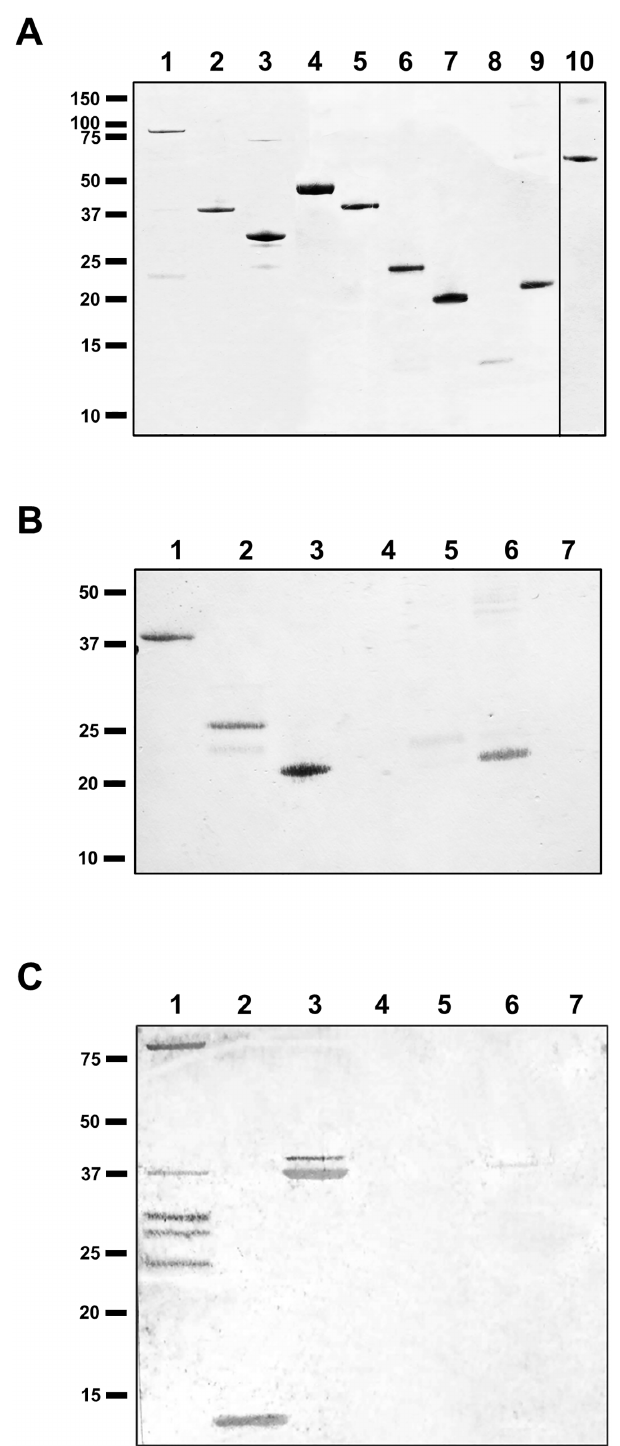
Fig 8. N-terminal PilG directly interacts with N-terminal PilQ monomer. Protein-protein interaction between recombinant meningococcal PilG and recombinant PilQ proteins were detected by a solid phase overlay assay (Far-western analysis). (A) A Coomassie Blue-stained gel showing recombinant proteins used. Lane 1, PilQ FL/1-761 ; lane 2, PilQ 25-354 ; lane 3 PilQ 217-478 ; lane 4, PilQ 350-761 ; lane 5, PilG FL/1-410 ; lane 6, PilG 1- 256 ; lane 7, PilG 1-178 ; lane 8, PilG 257-410 ; lane 9, PilG 166-410 ; lane 10 (added for comparison only), BSA. (B)